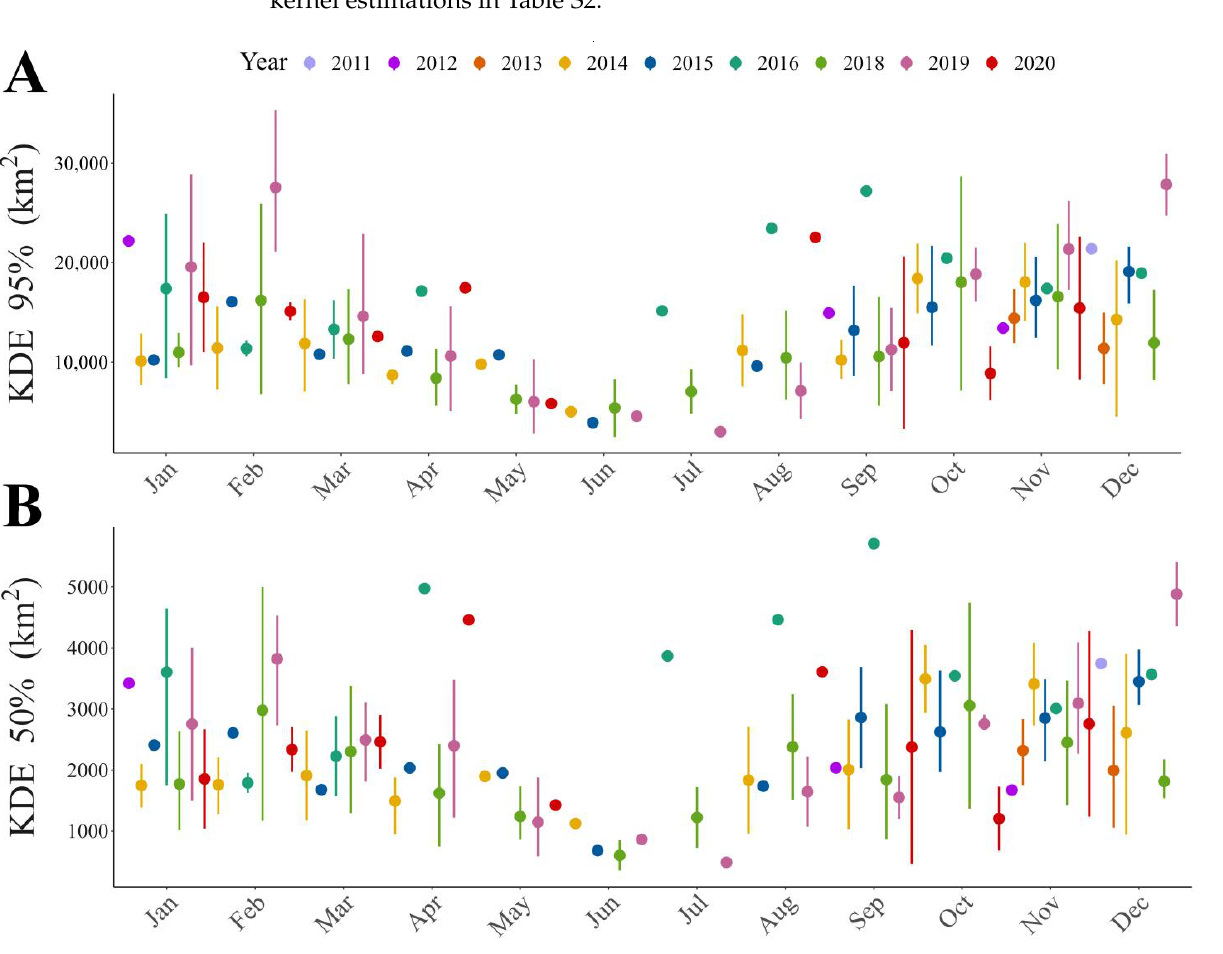
Figure 1. Trend throughout the year of home range size for different home range estimators: ( A ) Kernel Density Estimator (KDE) of 95% and ( B ) Kernel Density Estimator (KDE) of 50% of the contour area.